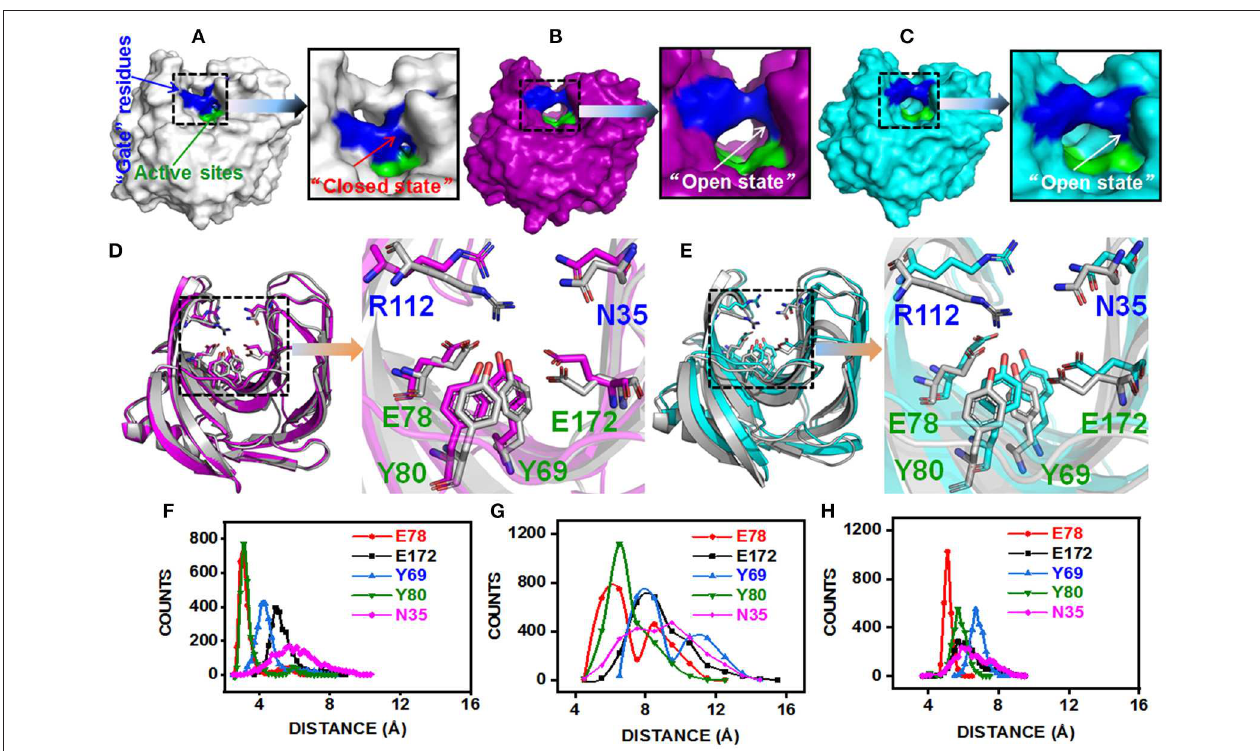
FIGURE 5 | Post-MD modeling presentation and key residues distance analysis of BaxA, DS241, and DS428. Surface representation of BaxA-WT, DS241, and DS428: (A) BaxA-WT (gray) in “closed state.” (B) DS241-S31R (purple) in “open state.” (C) DS428-I51V (cyan) in “open state.” (D) Key residues (R112, N35, E78, E172, Y69, and Y80) of BaxA and DS241. (E) Key residues (R112, N35, E78, E172, Y69, and Y80) of BaxA and DS428. Key residues were shown as a stick model. R112 and N35 belonged to the “gate” residues. E78, Y69, Y80, and E172 belonged to the active sites. The plots ( F , BaxA; G , DS241; H , DS428) showed the dramatic change in distance along MD simulations time, and the frequency distribution of distances between residue R112 and other key residues (E78, E172, Y69, Y80, and N35). Protein structures were generated and viewed by PyMOL 2.2.0 ( DeLano, 2002) and Chimera 1.13 (Pettersen et al.,